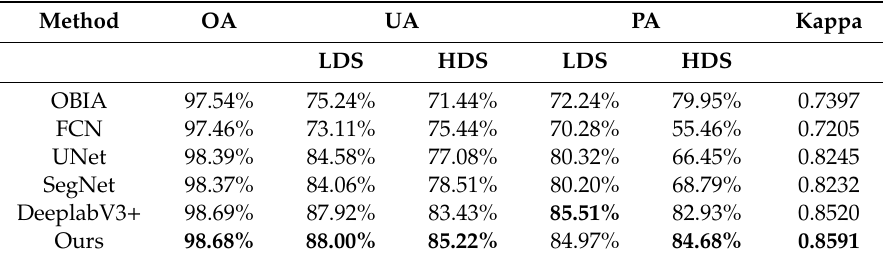
Table 5. Accuracy assessment of di ff erent methods, where values in bold are the best.